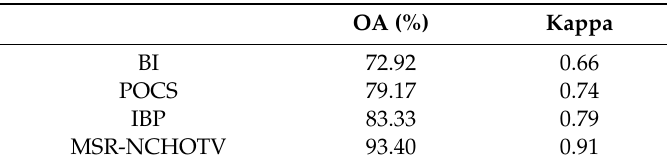
Table 8. The OA and Kappa coe ffi cient of the classification for Experiment 2 using the SRR images obtained using the four methods.